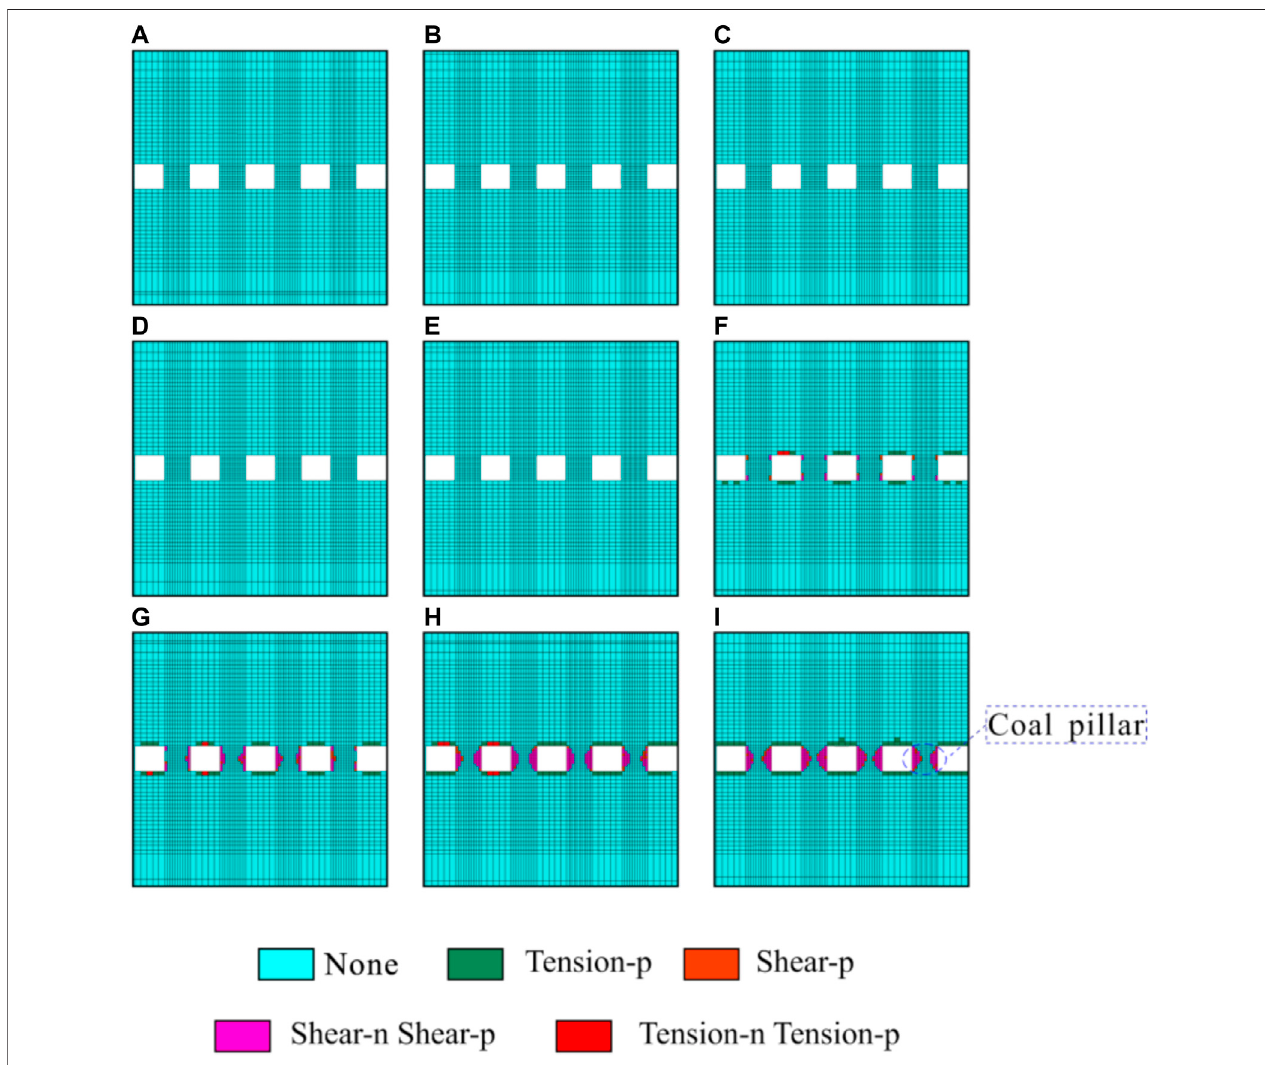
FIGURE 7 | Average width for the inelastic zone of the coal pillar in each section under the 0% fi lling rate condition. (A) 50 m; (B) 85 m; (C) 120 m; (D) 155 m; (E) 190 m; (F) 225 m; (G) 260 m; (H) 295 m; and (I) 330 m.